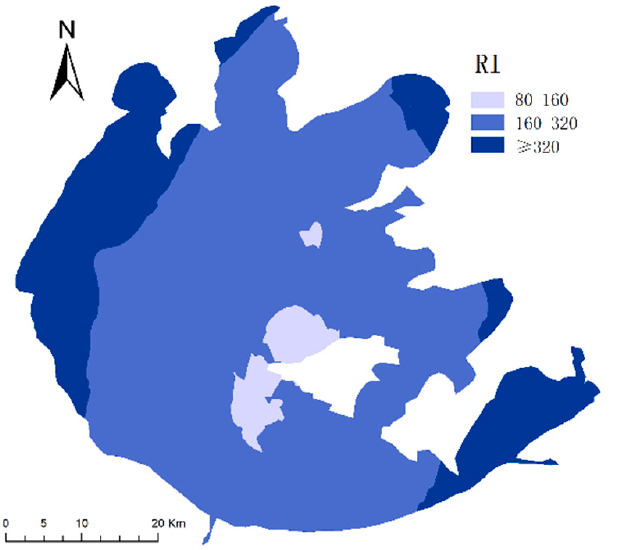
Figure 6. Spatial distribution of the ecological risk index (RI) of heavy metals in sediments in the study areas.